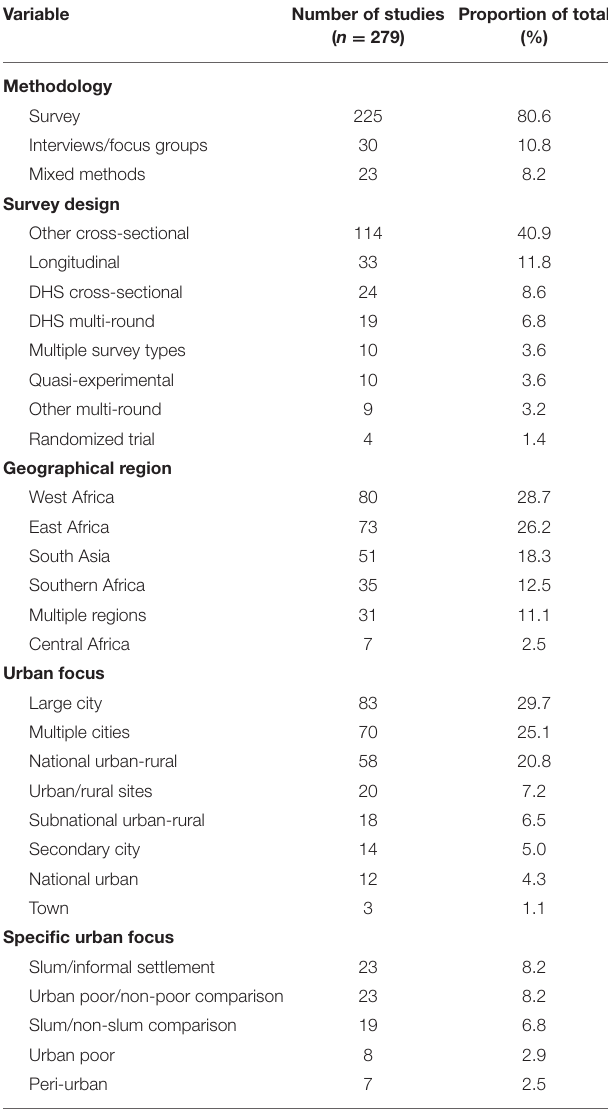
TABLE 1 | Number and proportion of reviewed studies, by category.